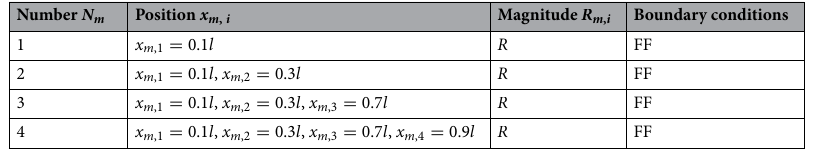
Table 3. Distribution of concentrated